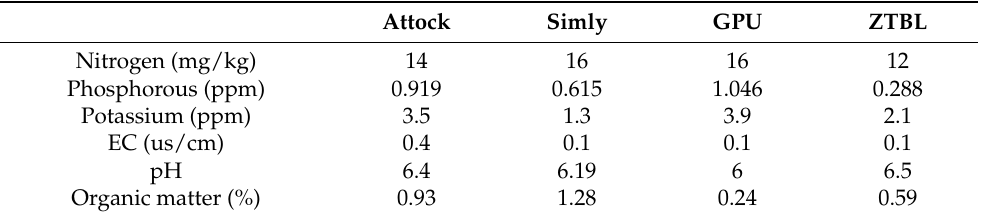
Table 1. Average data of chemical properties and nutrient status of soil collected through proximate soil sensors and soil fertility tests.